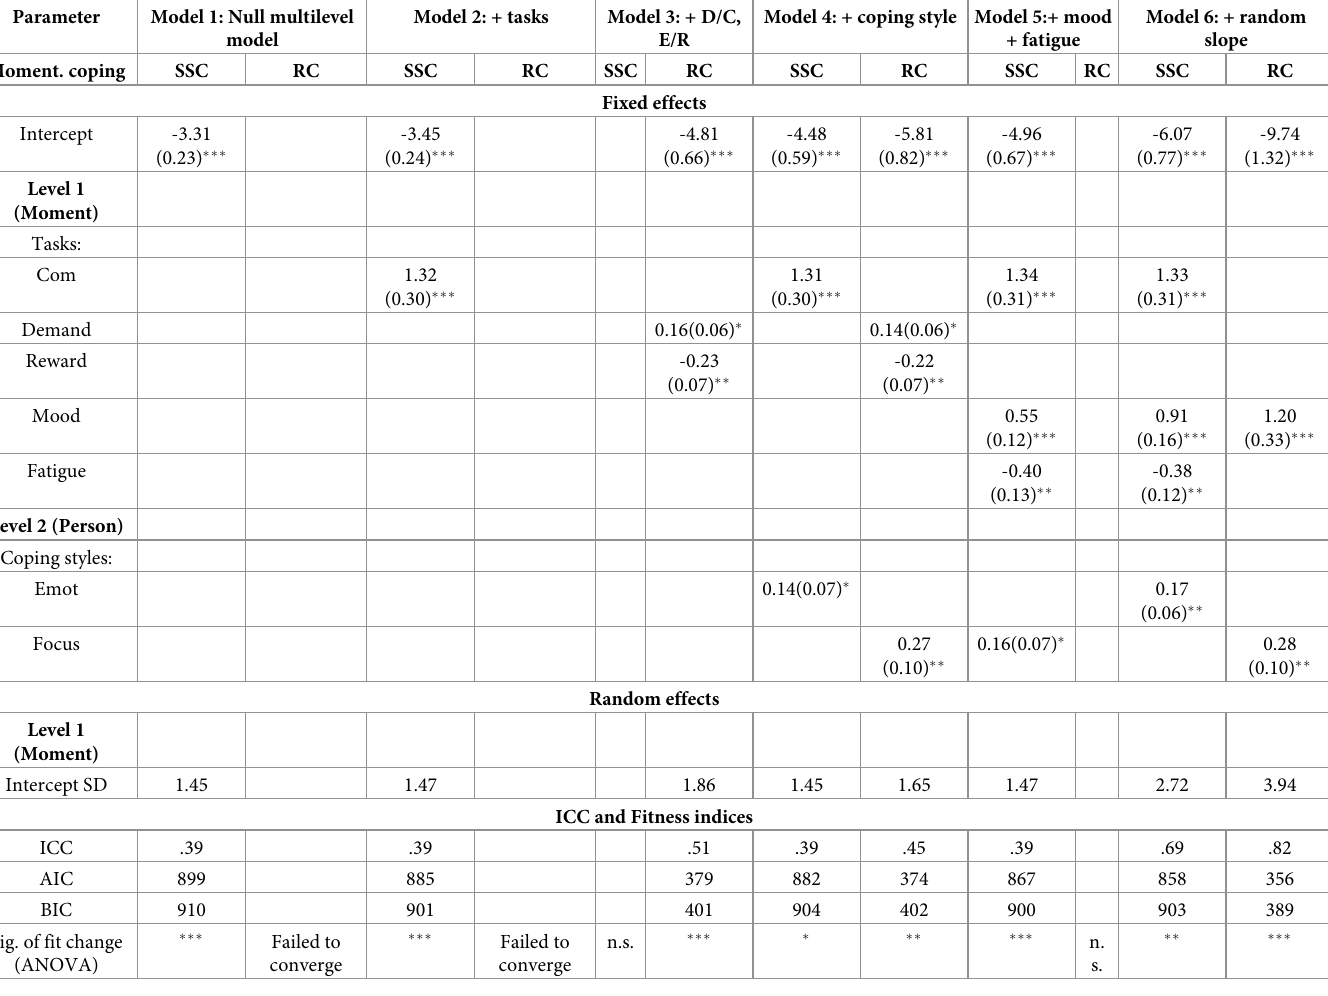
Table 2. Fixed effect (t-test, top) and variance estimates (standard deviation, bottom), and the fitness indices for models predicting support-seeking (SSC) and refusal coping (RC). Parameter Model 1: Null multilevel